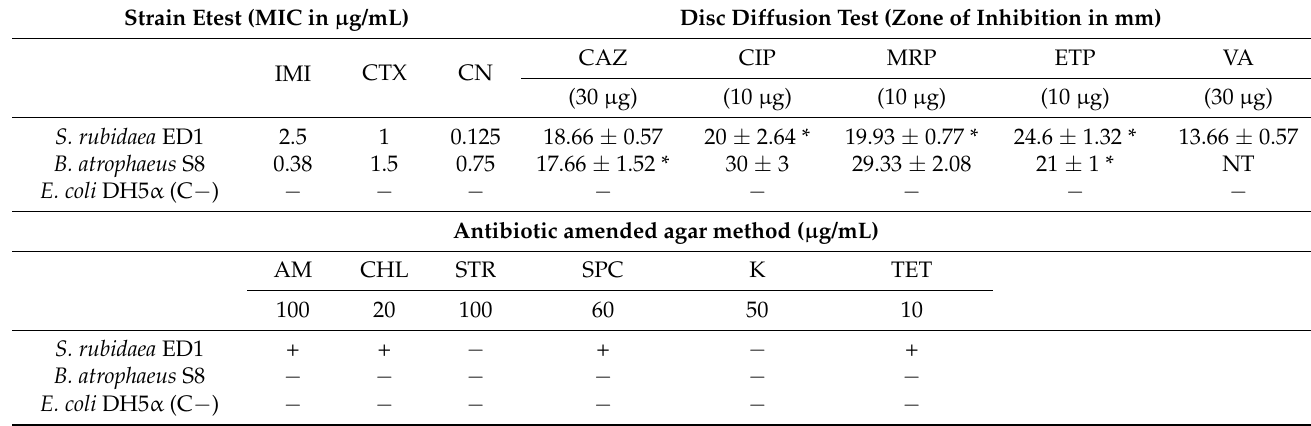
− − The values represent means of three replicates ( n = 3) ± SD. MIC (Minimum Inhibitory Concentration), CAZ (ceftazidim), IMI (imipenem), CIP (ciprofloxacin), CTX (cefotaxim), CN (gentamycin), MRP (meropenem), ETP (ertapenem), VA (vancomycin), AM (ampicillin), CHL (chloramphenicol), STR (streptomycin), SPC (spectinomycin), K (kanamycin), TET (tetracycline), NT (Not tested). Asterisk symbols (*) and the ‘+’ sign indicate resistance while the ‘ − ’ sign indicates susceptibility. Strains Bacillus atrophaeus S8, and E. coli DH5 α (C − ) were used as controls.